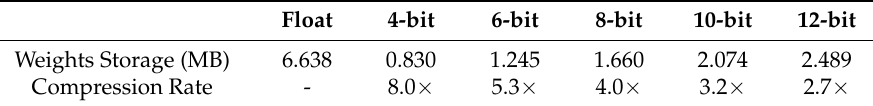
Table 5. Weights storage and compression statistics in experiments of quantized models.